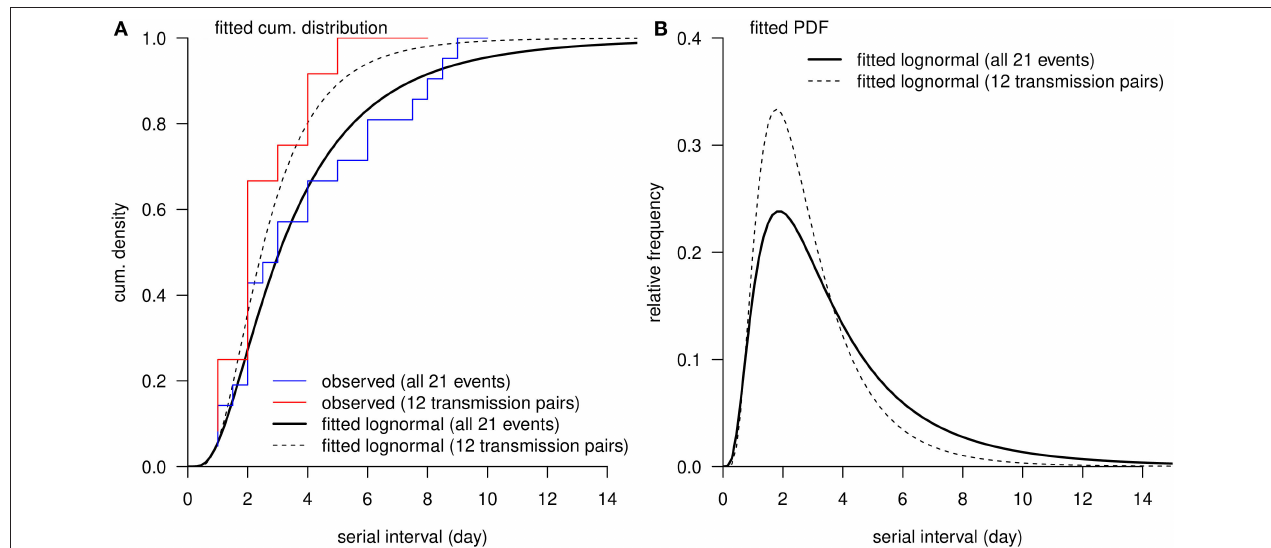
FIGURE 2 | The distribution of serial interval (SI). (A) , the red curve is the observed cumulative distribution of SI from 12 transmission pairs, and the blue curve is the observed cumulative distribution of SI from all 21 transmission events. (A,B) , the black bold curve is the fitted lognormal distribution using all 21 transmission events, and the dashed thin curve is the fitted lognormal distribution using 12 transmission pairs without